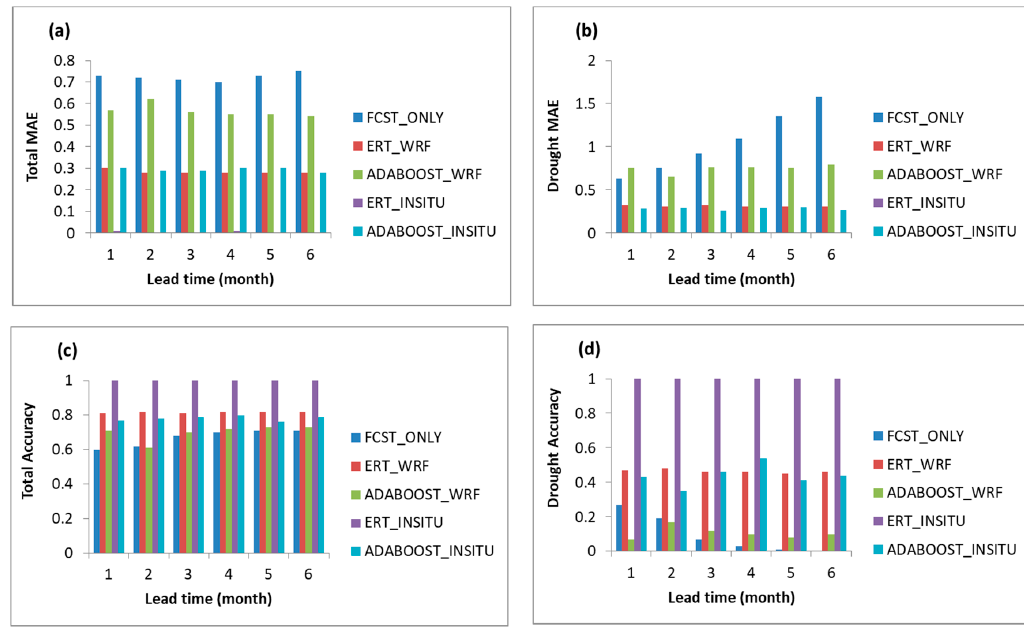
Figure 4. Training performance ( a ) Total MAE; ( b ) Drought MAE; ( c ) Total Accuracy; and ( d ) Drought Accuracy of SPI6 predictions from simply bias-corrected precipitation forecast (FCST_ONLY), Extra-Trees (ERT) and Adaboost trained using 80% of the WRF model outputs (ERT_WRF and Adaboost_WRF), and ERT and Adaboost trained using 100% of in-situ data (ERT_INSITU and Adaboost_INSITU).